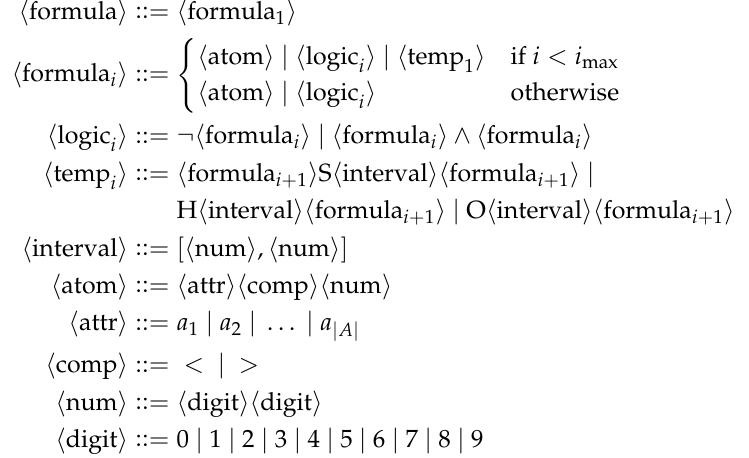
Figure 2. The CFG for describing STL formula structures. Non-terminal symbols are enclosed in angle brackets: the topmost non-terminal symbol, (cid:104) formula (cid:105) , is the starting symbol s 0 of the grammar. The derivation rules for the symbols (cid:104) formula i (cid:105) , (cid:104) logic the nesting level. The derivation rule for (cid:104) attr (cid:105) is the one that makes the grammar tailored to a given system with attributes A = { a 1 , a 2 , . . . , a | A | }